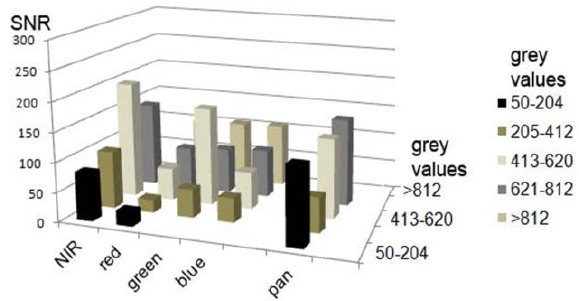
Figure 7. SNR for 16 bit images